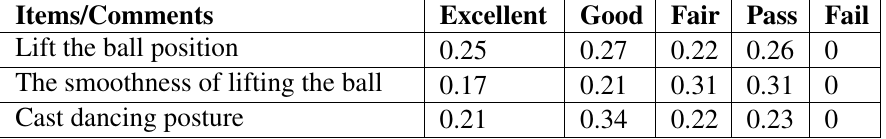
Table 4 Score of student 1 evaluated in the evaluation